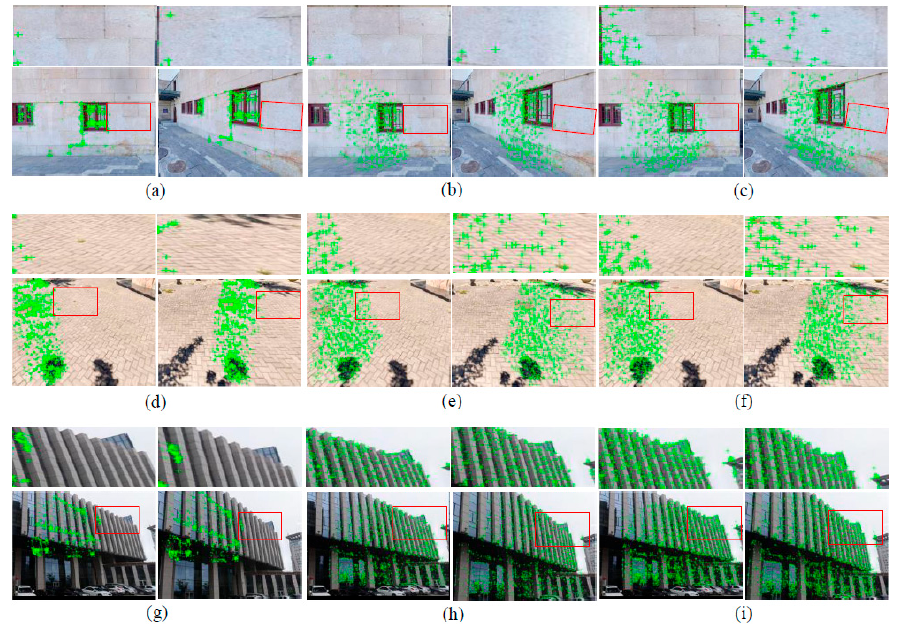
Figure 8. Matching results of the three methods tested on ground-based close-range stereo images JJ1–3. ( a , d , g ) tested on ASIFT. ( b , e , h ) tested on Brown-AffNet. ( c , f , i ) tested on SJRS-AffNet.